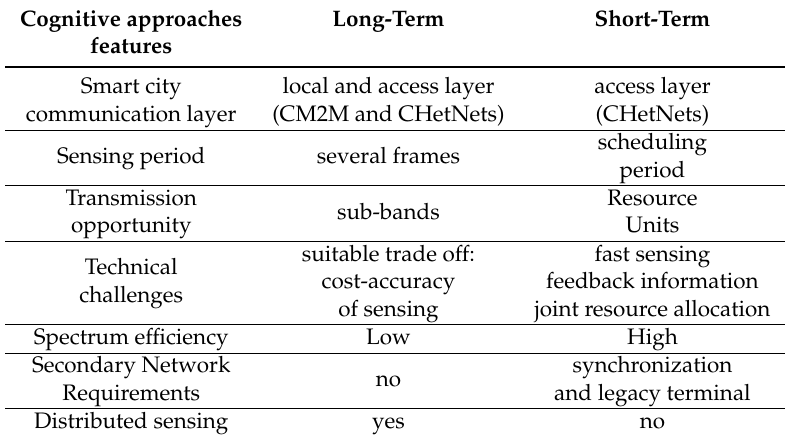
Table 1. Cognitive Approaches. CM2M: Cognitive machine-to-machine; CHetNet: Cognitive heterogeneous